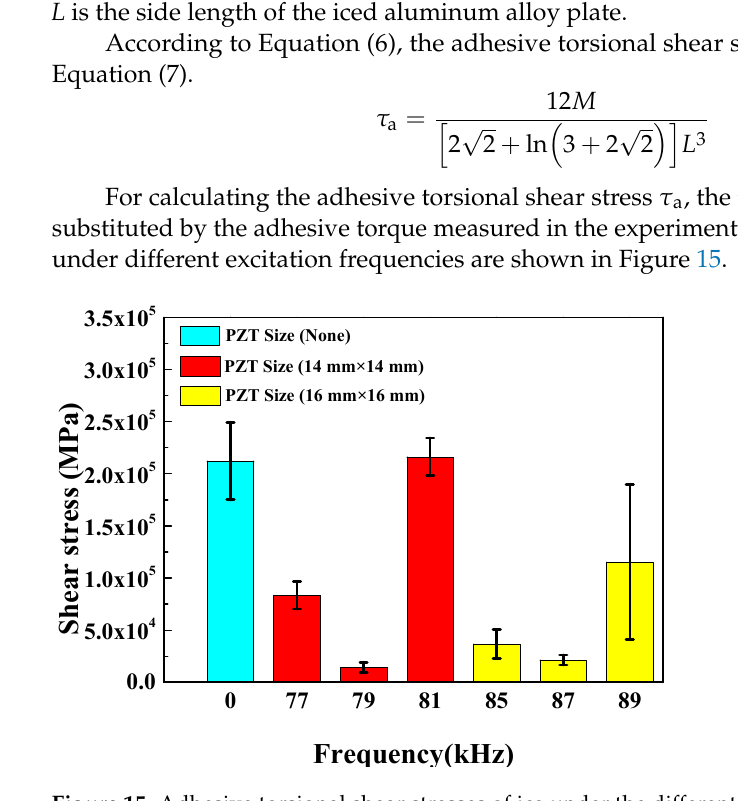
Figure 15. Adhesive torsional shear stresses of ice under the different frequencies.